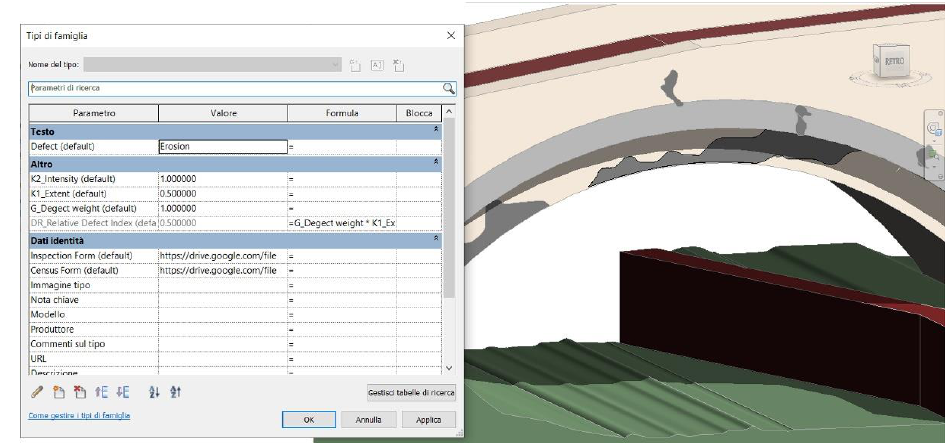
Figure 8 . Creation of new parameters according to visual inspection guideline.